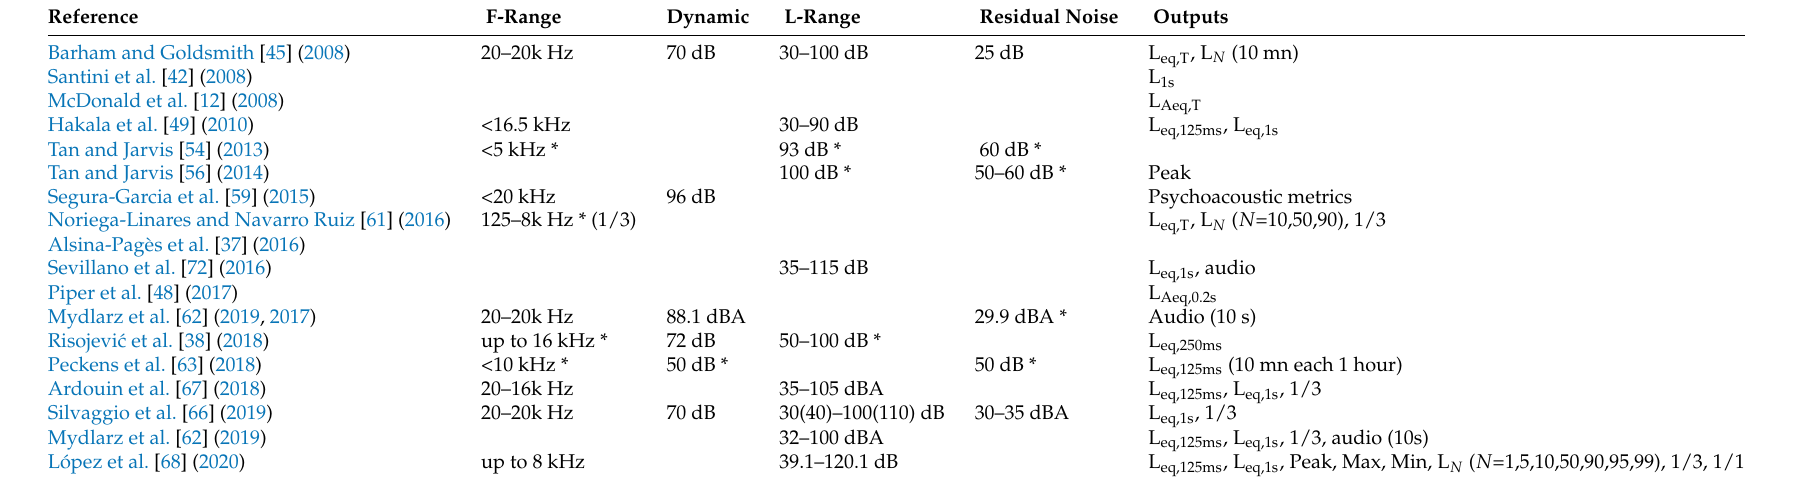
Table 2. Mean features of low-cost noise sensors detailed in the literature: frequency range, sound level dynamic, sound level range, residual noise, output